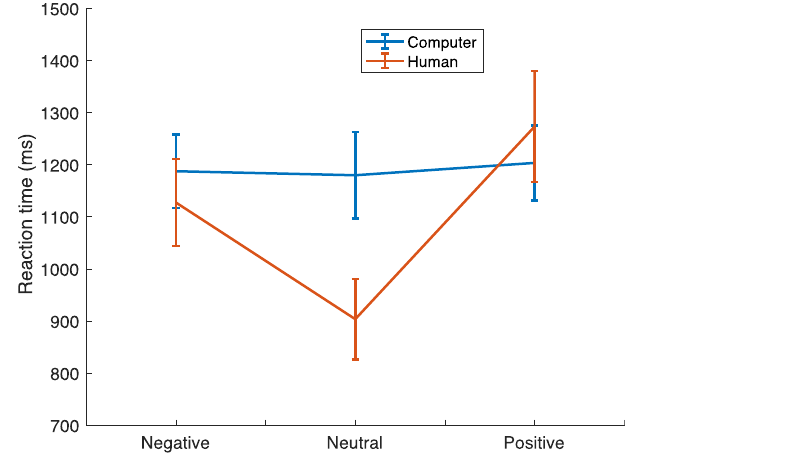
Fig 4. Response time when playing against a human and a computer. Response time when playing against a human and a computer partner across the three environmental contexts. Subjects were slower in the negative and positive environments when playing against a human partner. The error bars are standard errors.